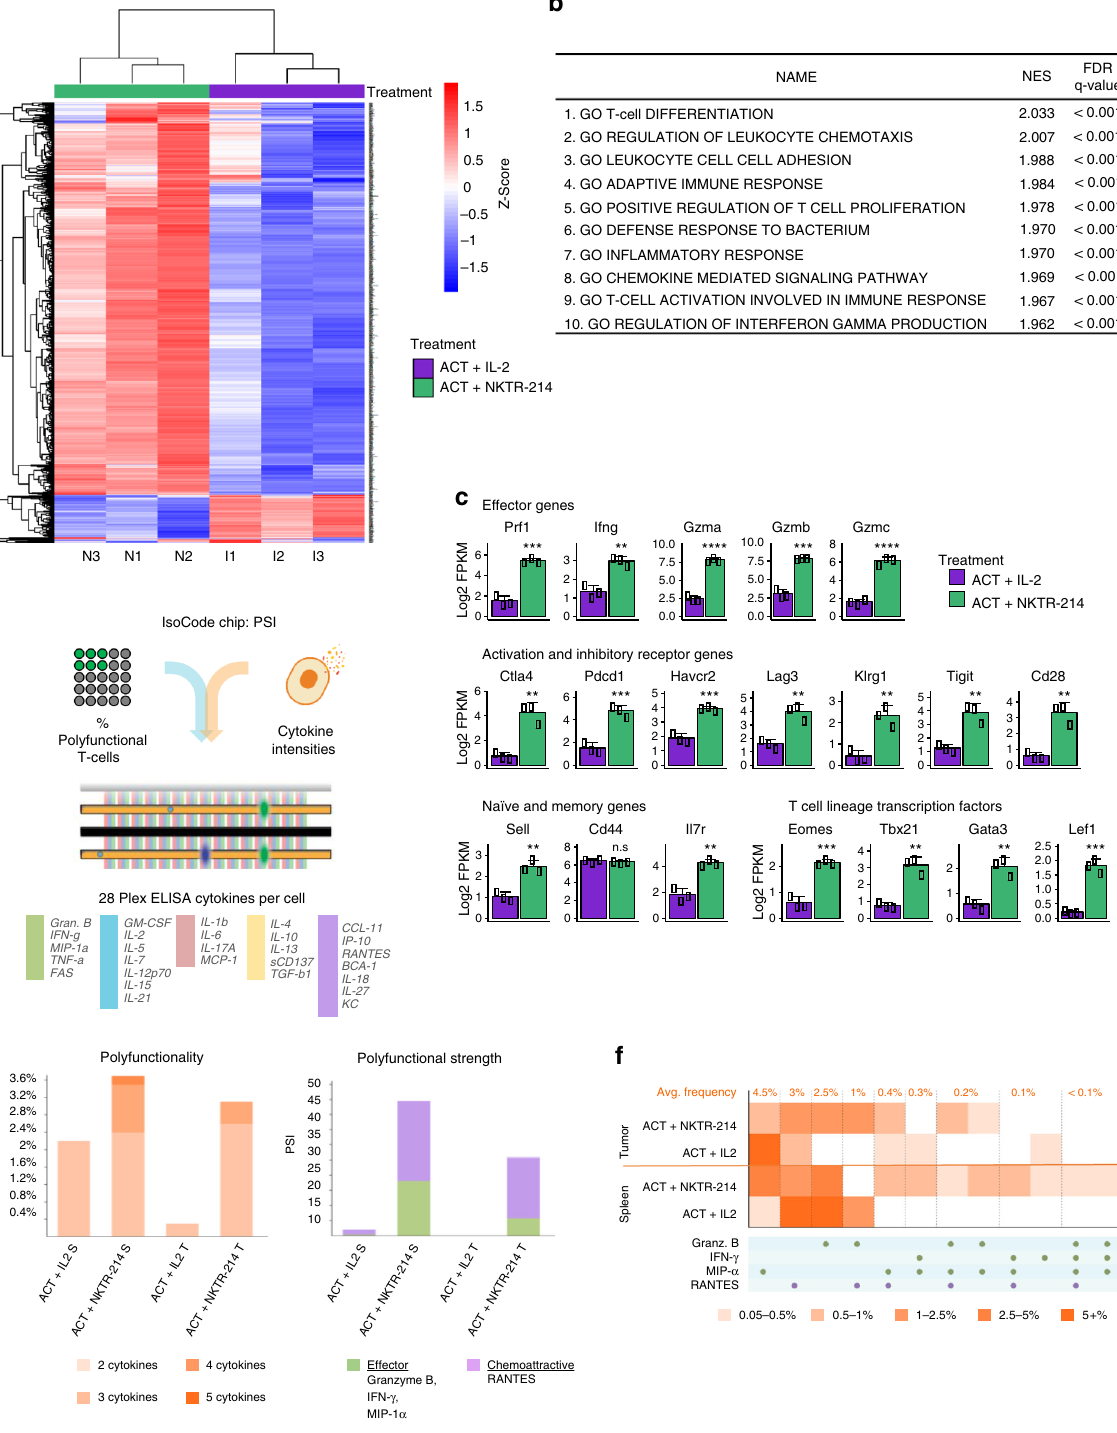
with NKTR-214 monotherapy . To explore if the administration pro fi le of CD4, CD8, and NK cells, as we noted in the mouse model, we used the same single cell polyfunctionality assay chip to analyzed peripheral blood mononuclear cells from fi ve patients treated with NKTR-214 within a phase I dose escalation study